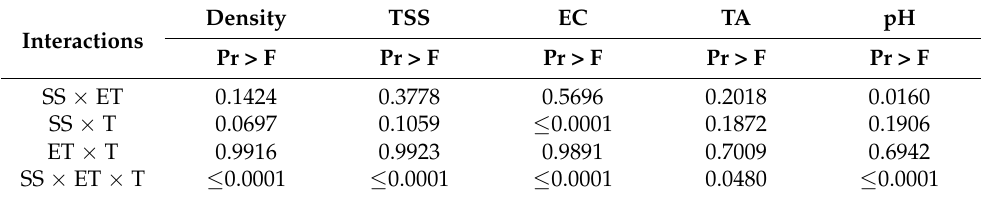
Table 1. Significanceanalysisofinteractionsofexperimentfactorsforanalysedphysicochemical parameters.